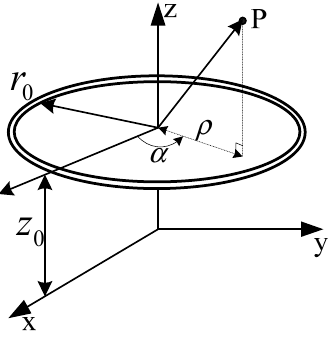
Figure 10. Circular equivalent